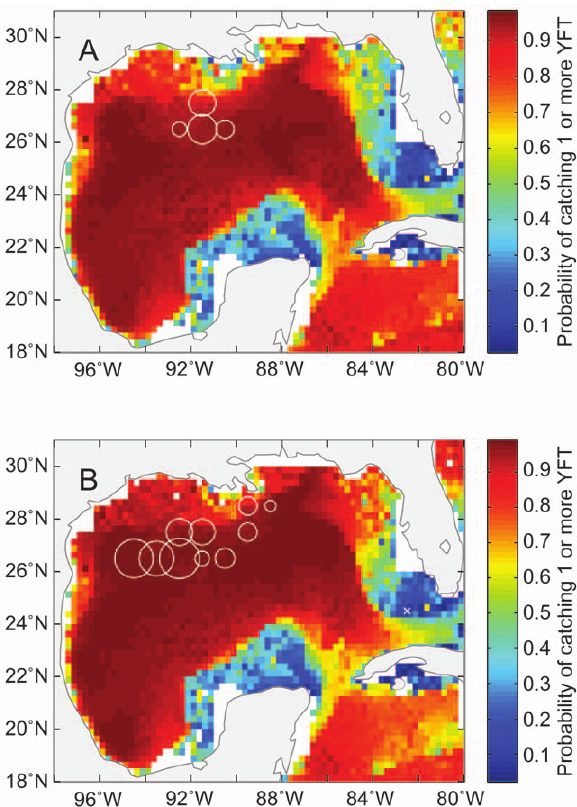
Figure 10. Map of sea surface height anomalies. Colors indicate sea surface height anomalies on 15 May (A) 2002 and (B) 2005.